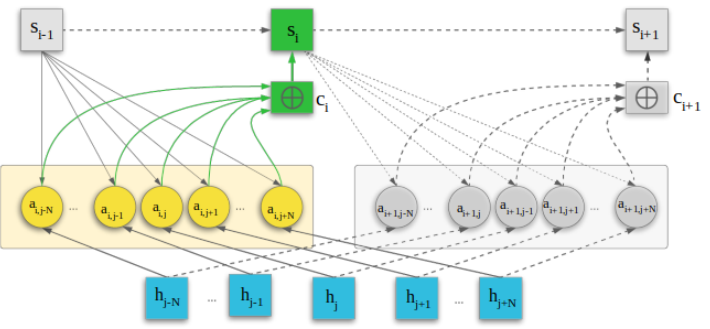
Figure 4. Illustration of attention layer, where a i , j = attention weight, c i = context vector, s i = attention target state, and (cid:76) =